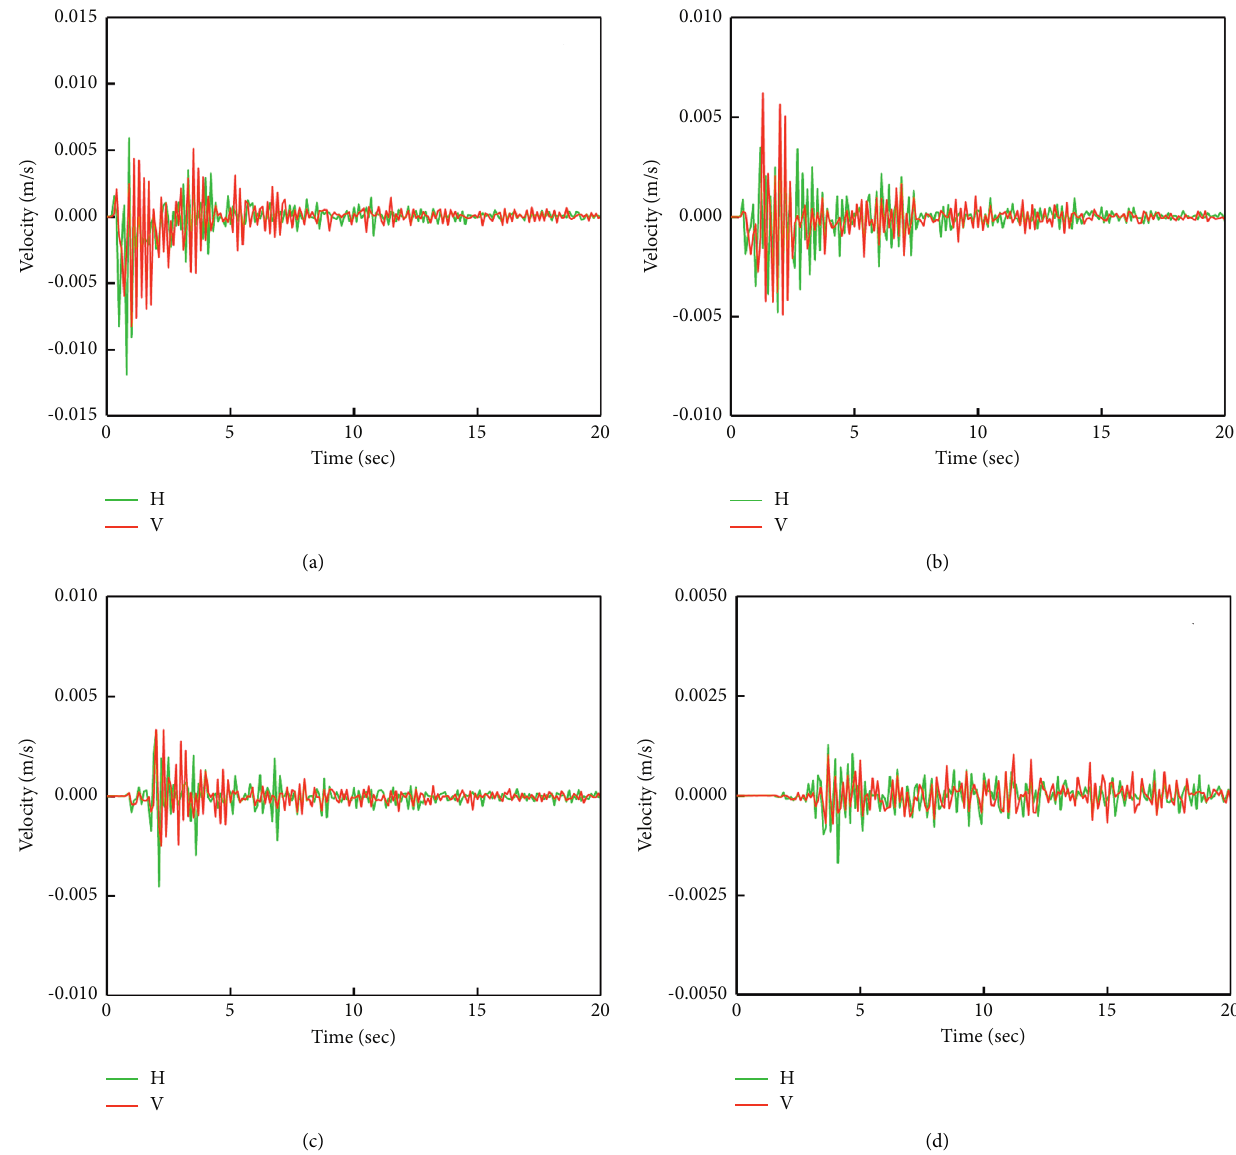
Figure 7: Time-history curves of the peak vertical vibration velocities at different measuring points with different distances: (a).50m measuring point, (b) 75m measuring point, (c) 100m measuring point, and (d) 200m measuring